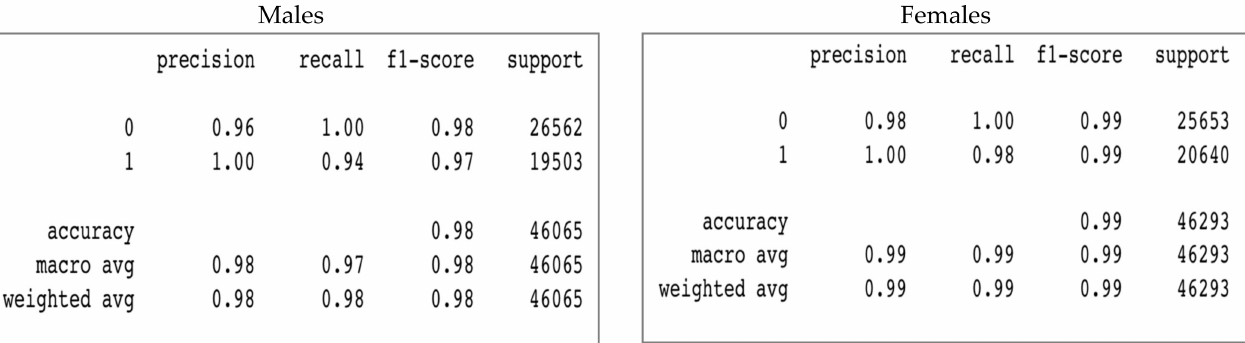
Figure 9. Classification Reports for ResNet50’s experiment